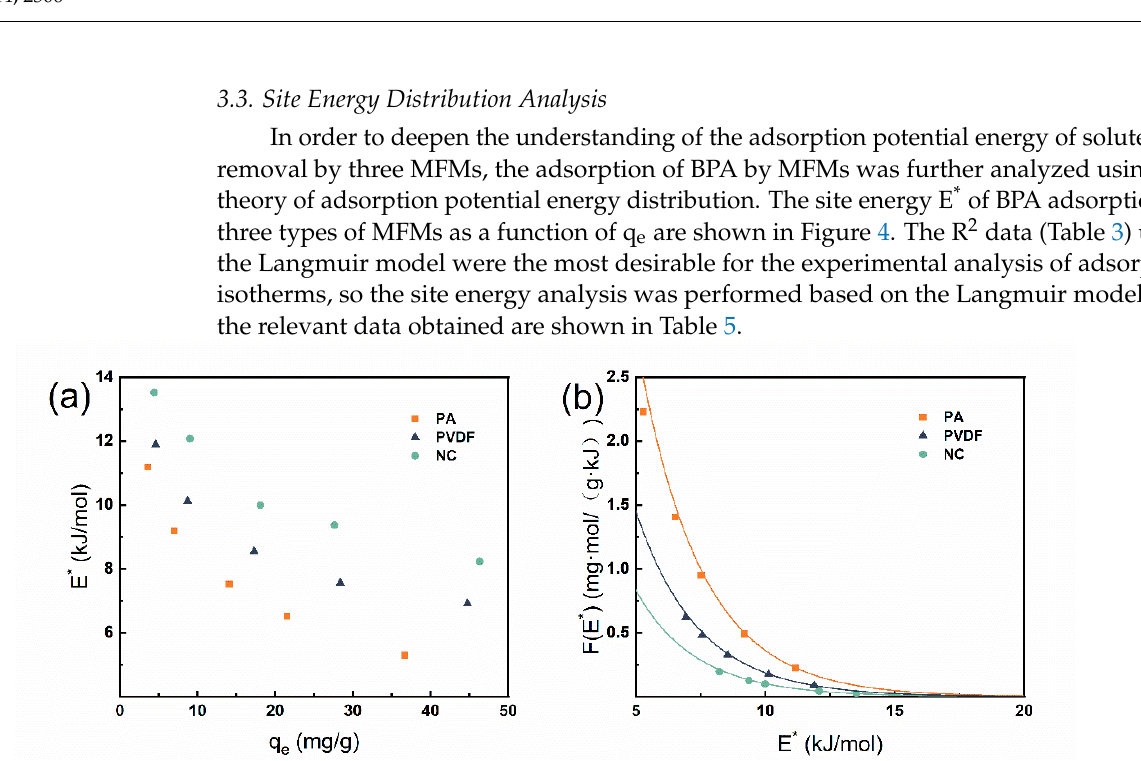
Table 5. The parameters of the adsorption energy distribution of BPA on different MFMs.